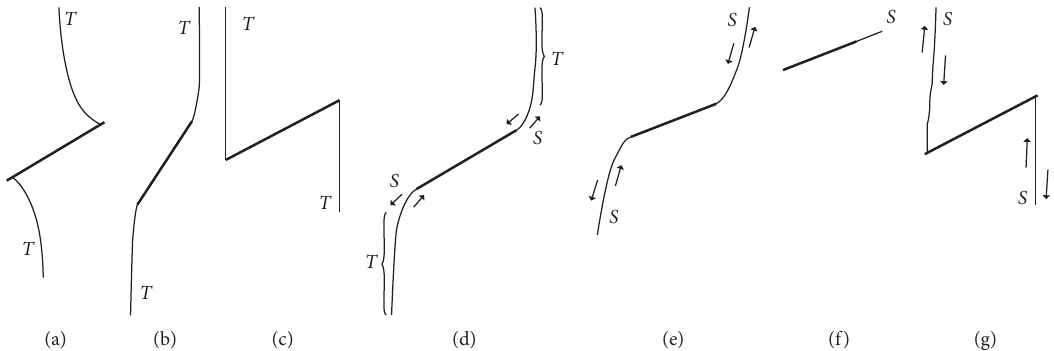
Figure 11: Various crack types initiated from the preexisting flaws identified [42]. T —tensile cracks. S —shear cracks. (a) Type 1 tensile crack (tensile wing crack). (b) Type 2 tensile crack. (c) Type 3 tensile crack. (d) Mixed tensile-shear crack. (e) Type 1 shear crack. (f) Type 2 shear crack. (g) Type 3 shear crack.